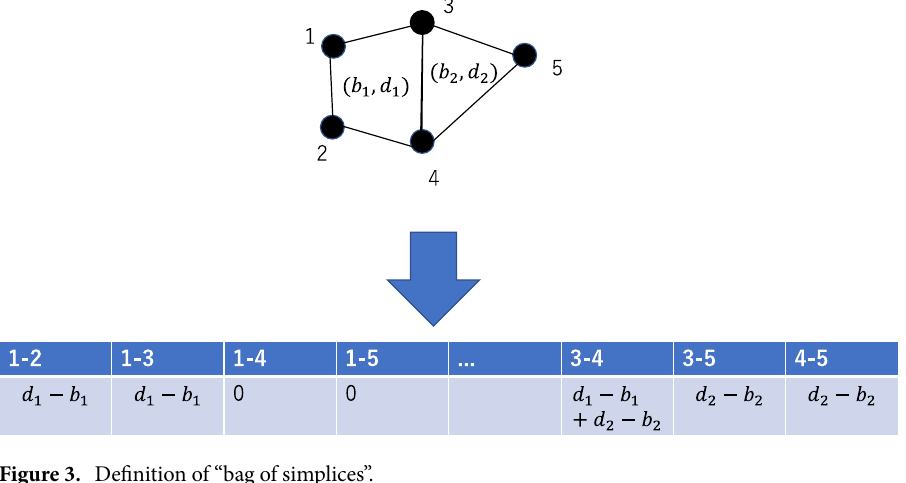
Figure 3. Definition of “bag of